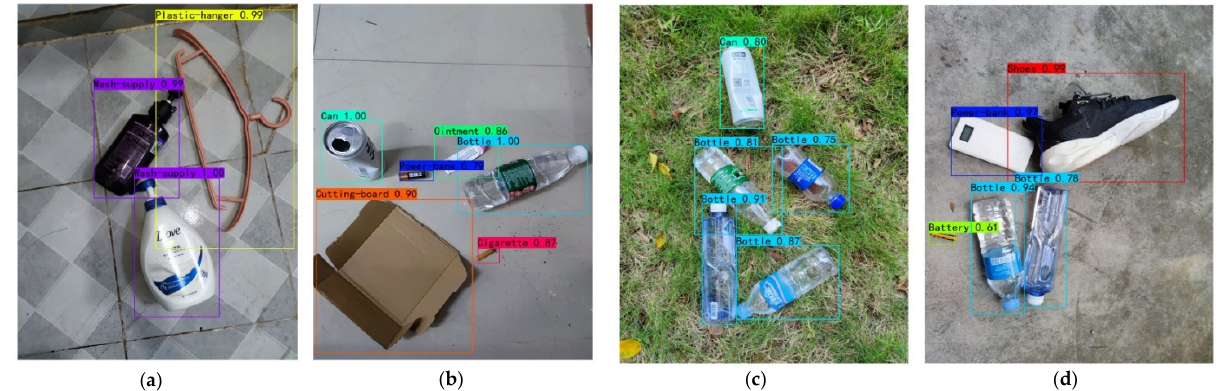
Figure 12. Application of i-YOLOX in multi-object scenarios. ( a ) is a bathroom scene to detect wash-supply and plastic-hanger. ( b ) is a corridor scene to detect cutting-board, can, ointment, bottle, cigarette and battery. ( c ) is the detection of can and bottle in the grass scene. ( d ) is a concrete floor scene to detect power-bank, shoes, battery and